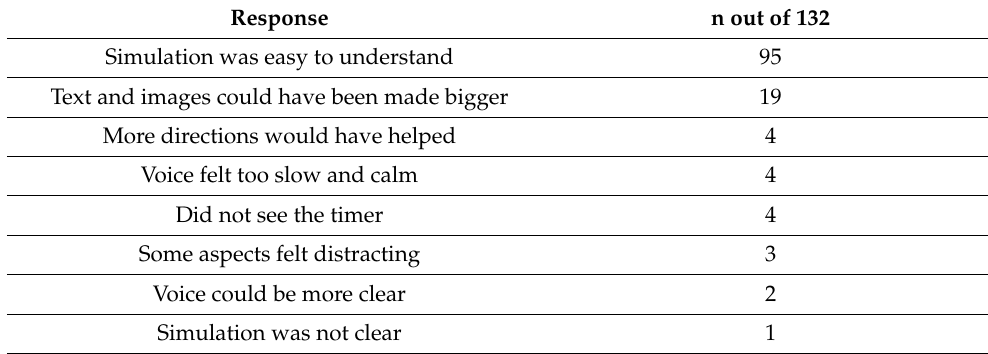
Table 6. How clear was the simulation? (Clarity of the voice, timer, and written instructions).